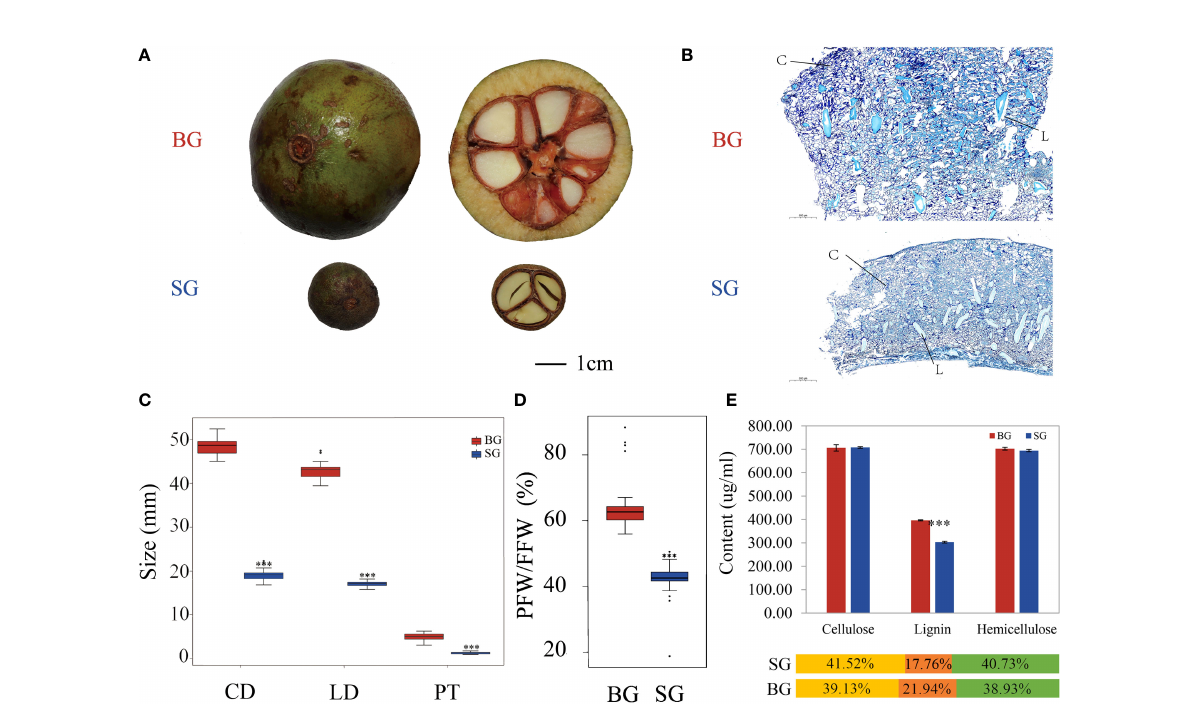
FIGURE 1 Comparison of fruit phenotypic characteristics between BG and SG. (A) Capsules of C drupifera (BG) and C oleifera Hu (SG); (B) Microscopic analyses of pericarps from BG and SG capsules; L, ligni fi ed cell wall; C, cellulose cell wall. (C) Comparison of cross diameter (CD), longitudinal diameter (LD), and pericarp thickness (PT) between BG and SG (D) Rate of pericarp fresh weight (PFW) to fruit fresh weight (FFW) between SG and BG. (E) Cellulose, lignin, and hemicellulose contents of BG and SG. Asterisks indicate a signi fi cant difference compared with BG; ***P < 0.001, Student ’ s t-test; Yellow: cellulose, orange: lignin, and green: